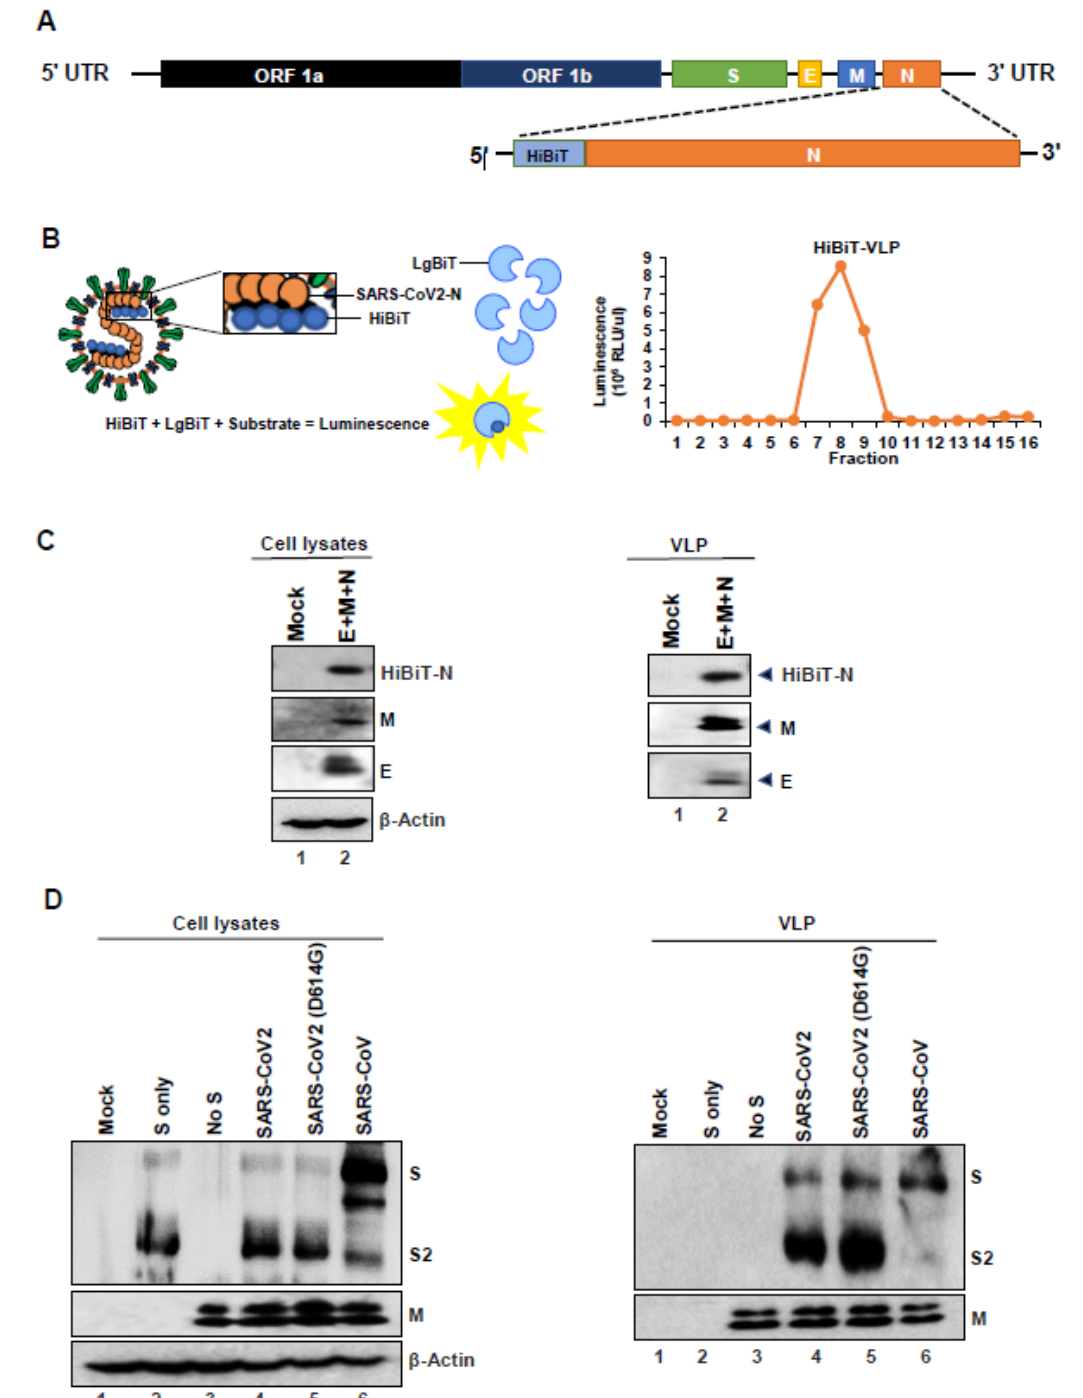
Figure 2. Production of SARS-CoV2 VLPs. ( A ) 11-amino acid HiBiT peptide was appended to the amino-terminus of N protein. ( B ) HiBiT-N within VLPs is detected using Binary NanoLuc Technology (NanoBiT). Addition of LgBiT protein and Nluc substrate generates luminescence within minutes of incubation. The right panel depicts elution of HiBiT-VLPs from size-exclusion chromatography (SEC) columns at or near void volumes (fractions 7–9). ( C ) Western blot (WB) images depict E, M, and N proteins in cell lysates of plasmid-transfected HEK-293T cells (left) and in size-exclusion chromatography (SEC)-purified VLPs (right). VLPs were harvested at 24 h post-transfection. ( D ) Plasmids encoding the spike protein of SARS-CoV2, SARS-CoV2 variant (D614G), and SARS-CoV were co-transfected with the E, M, and HiBiT-N of SARS-CoV2. WB images depict S and M proteins in cell lysates (left) and purified VLPs (right). SARS-CoV2 S proteins are cleaved into S1 and S2 during VLP secretion, while SARS-CoV S remains